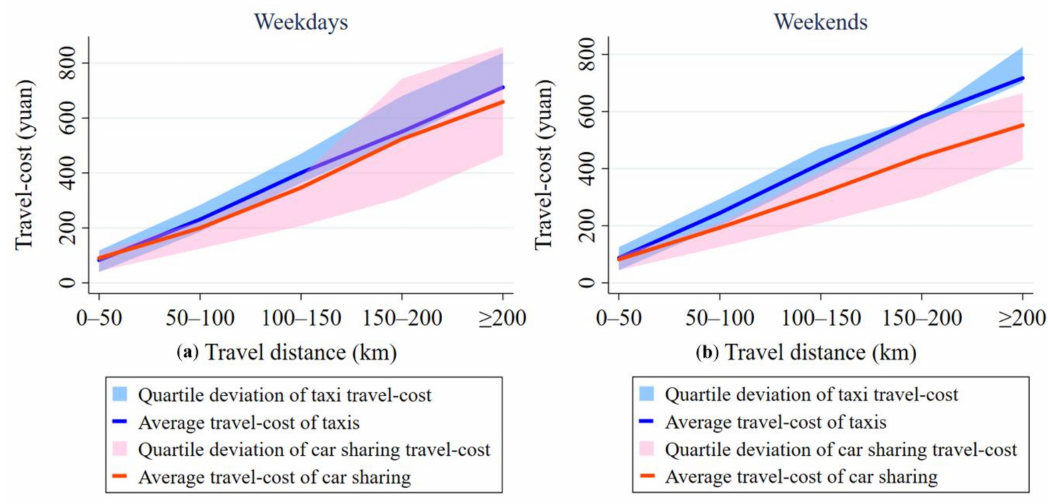
Figure 12. Comparison of travel-cost between taxis and car sharing in di ff erent travel distances on weekdays ( a ) and on weekends ( b